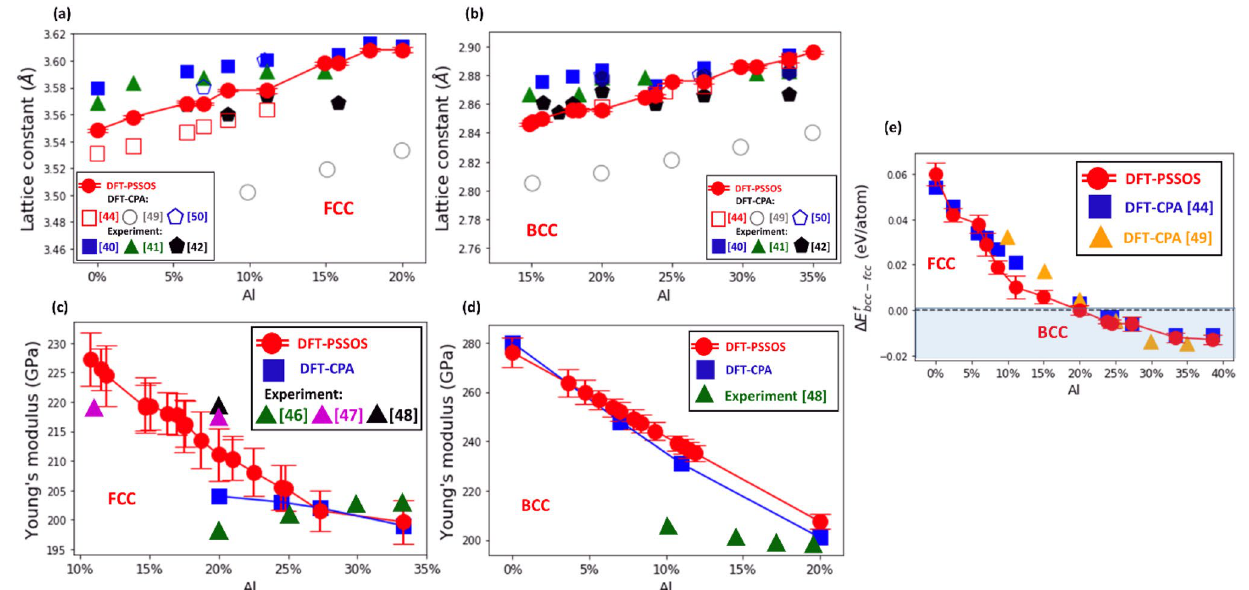
Figure 6. ( a ), ( b ) Lattice constant of Al x (CoCrFeNi) 1-x in FCC ( a ) and BCC ( b ) phase vs. molar fraction of Al. The values of lattice constant obtained by the PSSOS method are represented by red circles; the error-bars represent standard deviations, and the red line is a guide to the eye. The experimental measurements are taken from Chou et al. 40 (blue squares), Wang et al. 41 (green triangles), and Zhu et al. 42 (black pentagons), while the values obtained by CPA-based DFT calculations are taken from Jasiewicz et al. 44 (open circles), Tian et al. 49 (open squares), and Leong et al. 50 (open pentagons). ( c ), ( d ) The Young’s modulus of Al x (CoCrFeNi) 1-x in FCC ( c ) and BCC ( d ) phase is plotted against molar fraction of Al. The values of elastic modulus calculated by the PSSOS method (red circles) are compared with those calculated by the CPA-based DFT method 49 (blue squares). The experimental measurements are taken from Li et al. 46 (green triangles), Jiao et al. 47 (orange triangles) and Mohanty et al. 48 (magenta triangles) ( e ) Difference between the formation energy per atom of Al x (CoCrFeNi) 1-x f in BCC and FCC phase as a function of molar fraction of Al. The energy differences, (cid:31) E bcc − fcc , obtained by the f PSSOS method are represented by red circles, the (cid:31) E bcc − fcc obtained by the CPA-based DFT calculations are taken from Jasiewicz et al. 44 (orange triangles) and Tian et al. 49 (blue squares). The dashed line separates the f ≥ 0 , where the FCC phase is more stable than BCC, and (cid:31) E f ≤ 0 where the BCC region with (cid:31) E bcc − fcc bcc − fcc phase is more stable than